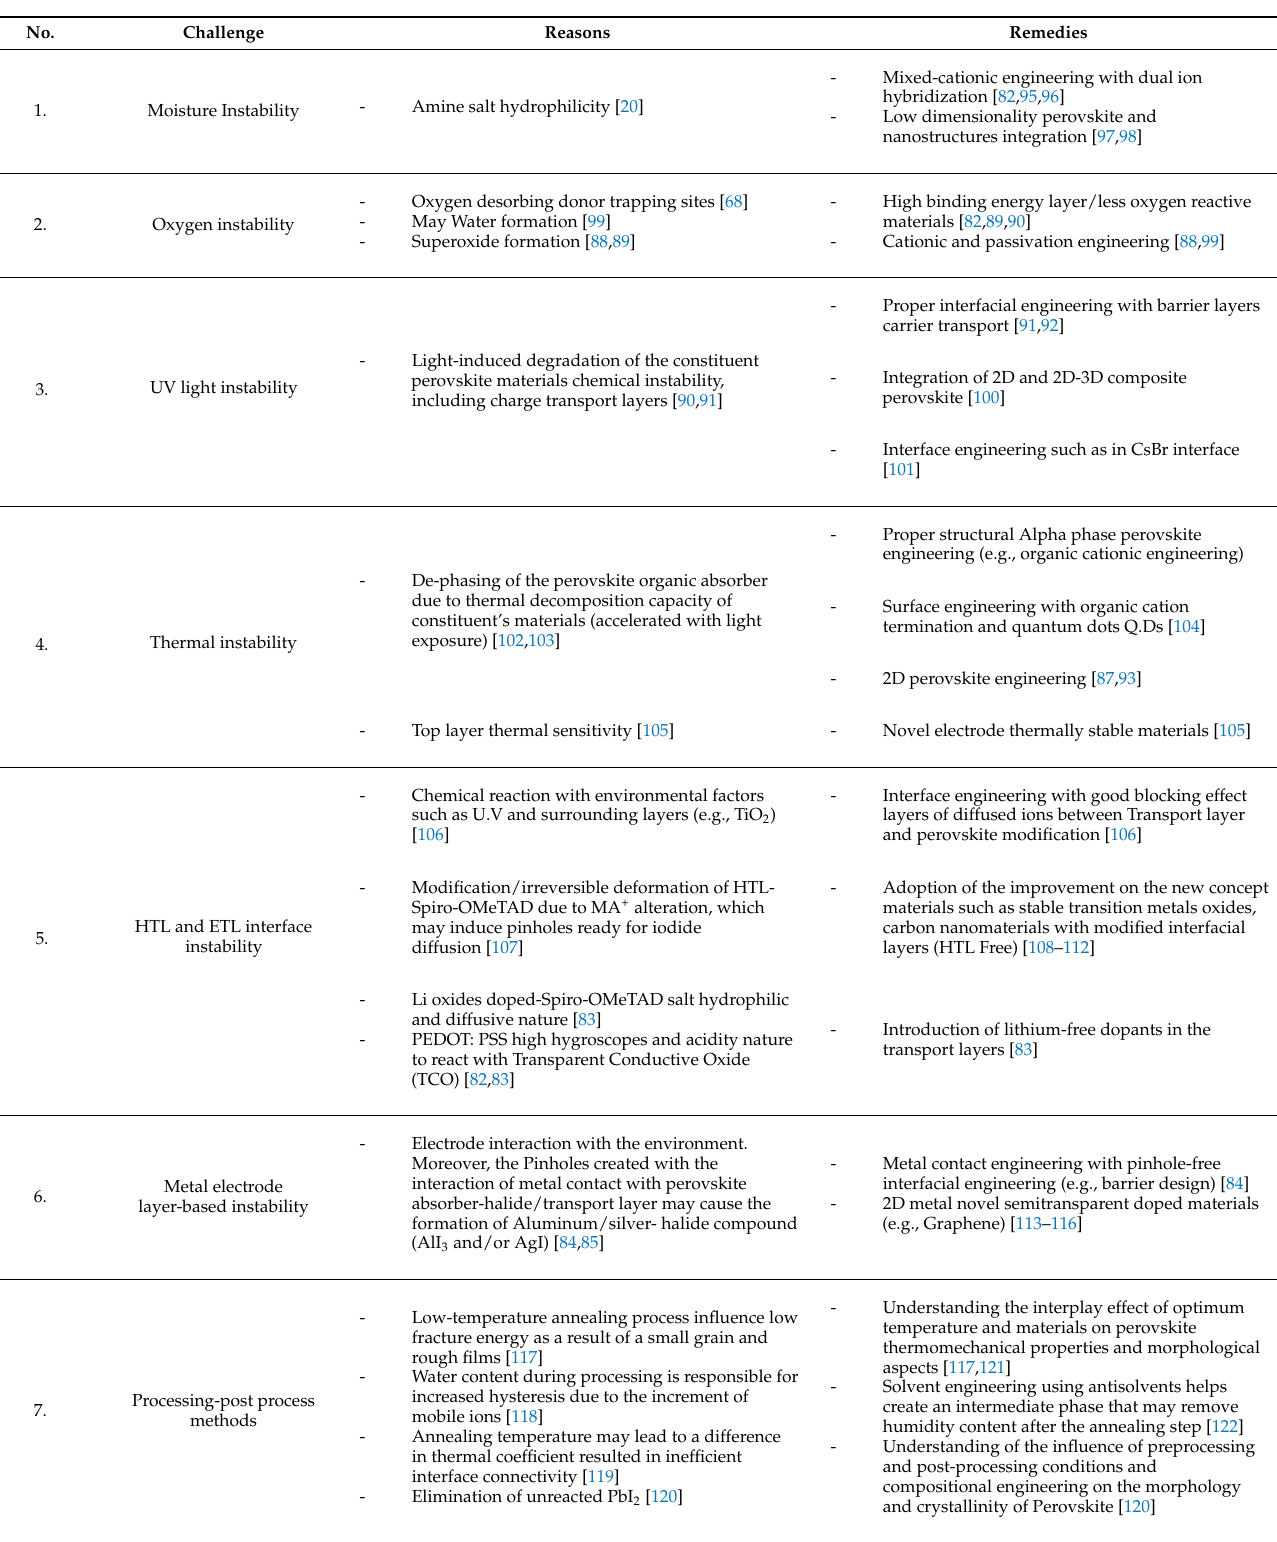
Table 4. The summaries of the significant stability sub-challenges with physical basis along with proposed heal- ing/mitigation strategy